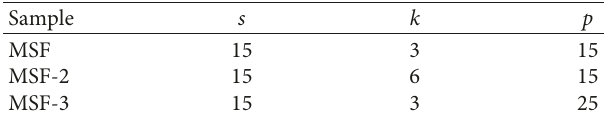
Table 6: The mix proportion of pastes in the isothermal conduction calorimetry test.